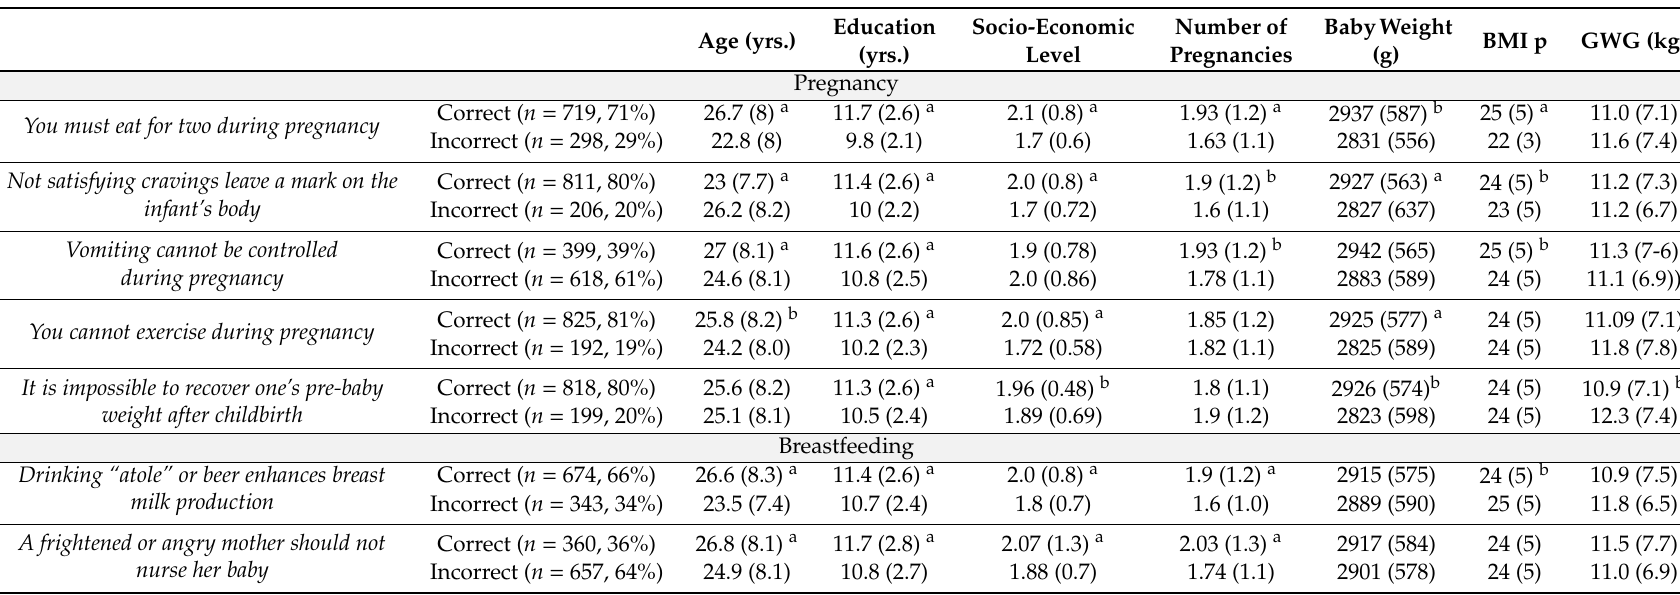
Table 3. Maternal and neonatal variables associated with belief in dietetic myths during pregnancy and breastfeeding, mean (standard deviation). Age (yrs.)